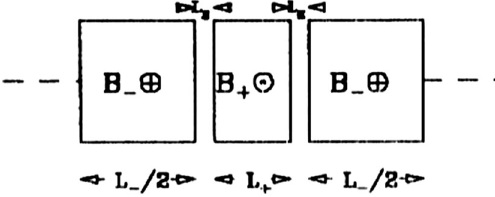
FIG. 1. LEP polarization wiggler (figure from